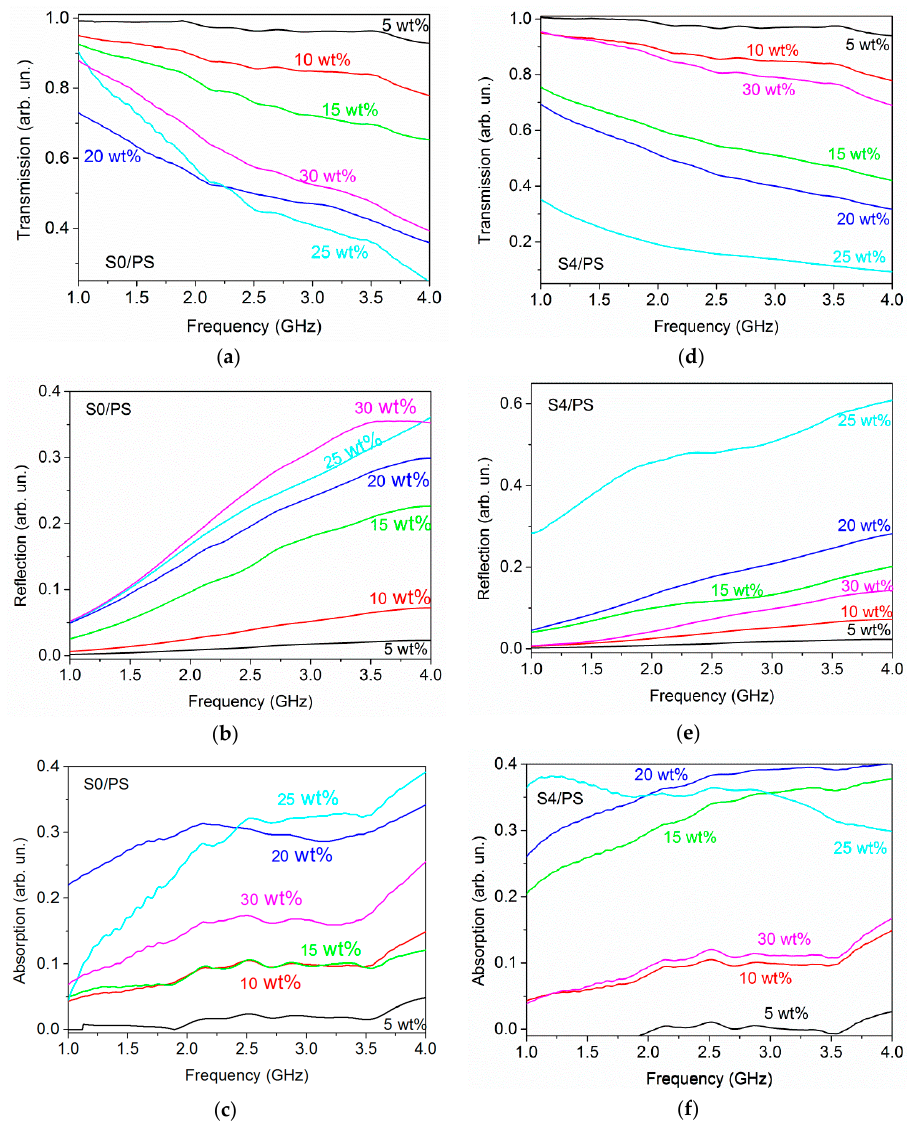
Figure 6. Transmission, reflection, absorption of S0/PS ( a – c ) and S4/PS ( d – f ) composites.